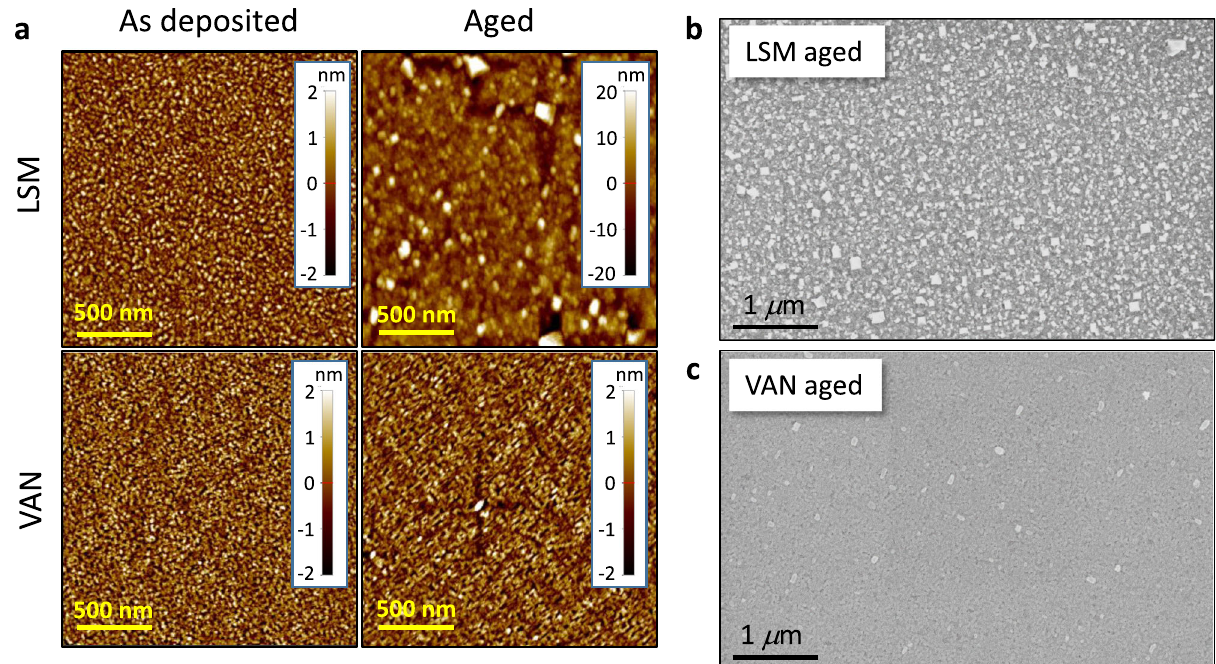
Fig. 4 AFM and SEM top-view micrographs for LSM and LSM-SDC. In ( a ), a full comparison between the surfaces of the two compounds in the as-grown and aged states is provided. The resulting root mean square roughness are: R ms = 0.8 (7.1) and R ms = 0.7(1.0) nm for LSM-SDC and single phase LSM as grown (after ageing), respectively. In ( b – LSM) and ( c — VAN), lower magni fi cation SEM for the surfaces after thermal treatment (In-Lens detector – 3 kV acceleration